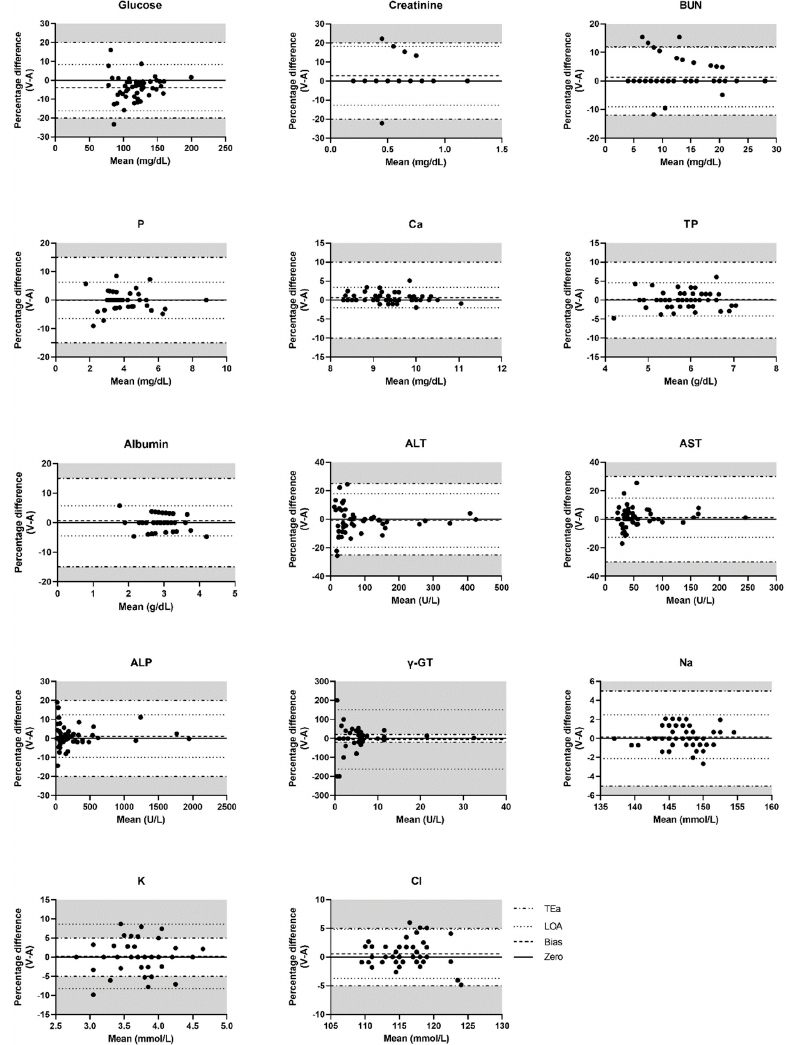
Figure 2. Bland–Altman plots of biochemical parameters comparing arterial and venous blood samples. The percentage difference of venous and arterial results is plotted against the mean of the venous and arterial results. Gray shading indicates the area exceeding the allowable total error (TEa). If the upper and lower lines of the LOA are not within the gray shading, it indicates clinical interchangeability between the venous and arterial results. BUN, blood urea nitrogen; P, phosphate; Ca, calcium; TP, total protein; ALT, alanine aminotransferase; AST, aspartate aminotransferase; ALP, alkaline phosphatase; γ -GT, gamma-glutamyl transpeptidase; Na, sodium; K, potassium; Cl, chloride; LOA, limit of agreement.